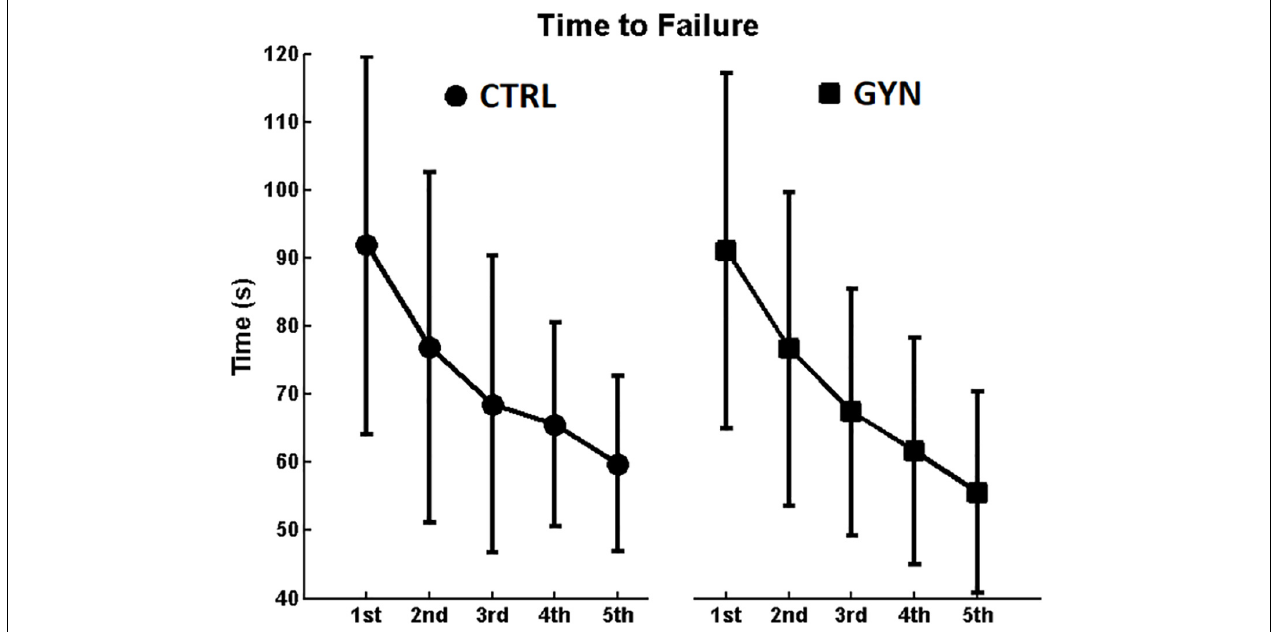
FIGURE 2 | Average duration (time to failure) of each of the 5 fatiguing contraction performed by the participants. Values associated with the controls (CTRL) and gymnasts (GYN) groups are represented by circles (left panel) and squares (right panel), respectively. Note the clear tendency to decrease time to failure (indicating a reduction in endurance performance) along the repetitions, yielding a significant main effect of time ( P < 0.001). No significant main effect of group was observed neither significant interactions between group and time ( P > 0.05), indicating that gymnasts showed similar performance during the fatiguing protocol as compared to the